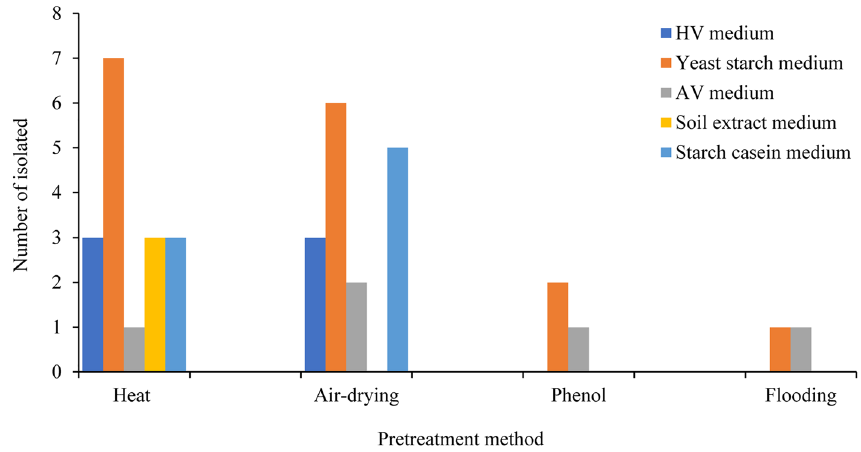
Figure 5. Number of actinobacteria cultured on different isolation media were sorted from differentially pretreated lichens (heat, air-drying, phenol, and flooding).